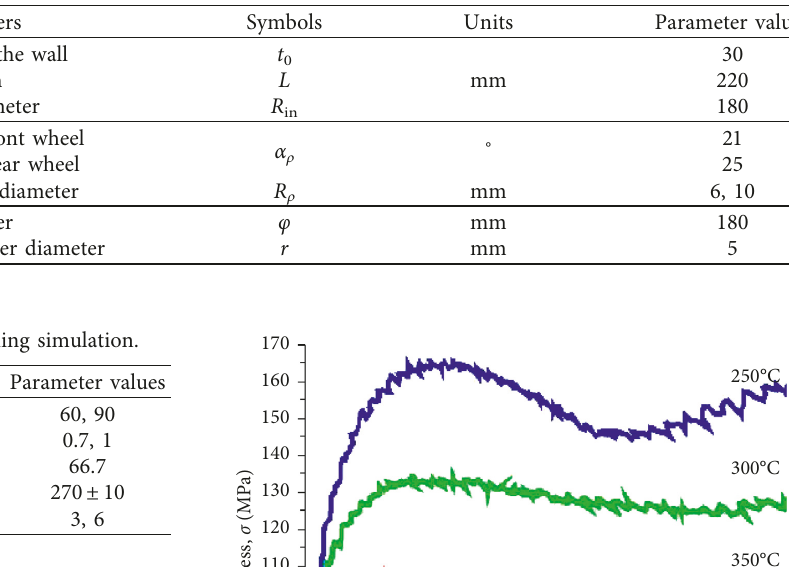
Table 1: Parameter values of various components in the simulation model.